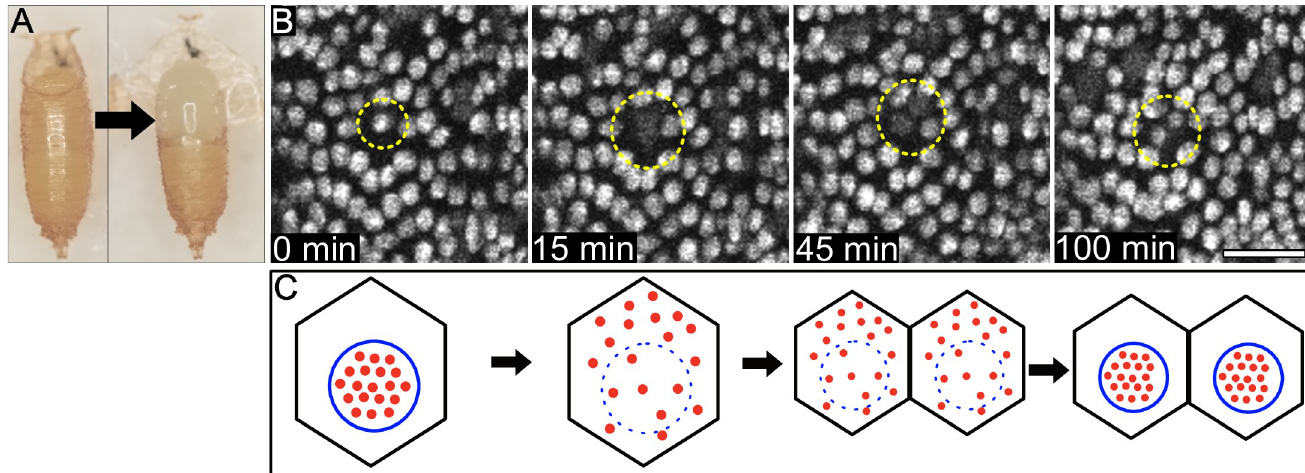
Fig 1. mCherry.NLS reports nuclear envelope integrity. (A) An intact Drosophila pupa (left) and one prepared for imaging with the pupal case partially removed (right), exposing the pupal notum. (B) Interphase nuclei in unwounded tissue are labeled by mCherry.NLS driven by the Gal4/UAS system. During mitosis, the fluorescence signal evident at 0 min disperses when the nuclear envelope breaks down, seen within circles in panels at 15 min and 45 min, before reappearing as two distinct/punctate nuclei at 100 min. (C) A schematic showing the diffusion of mCherry.NLS out of the nucleus during mitosis and its concentration in nuclei again after the nuclear envelope reforms in the daughter cells. Thus, the localization of mCherry.NLS reports nuclear membrane integrity. Scale bar = 25 μ m.